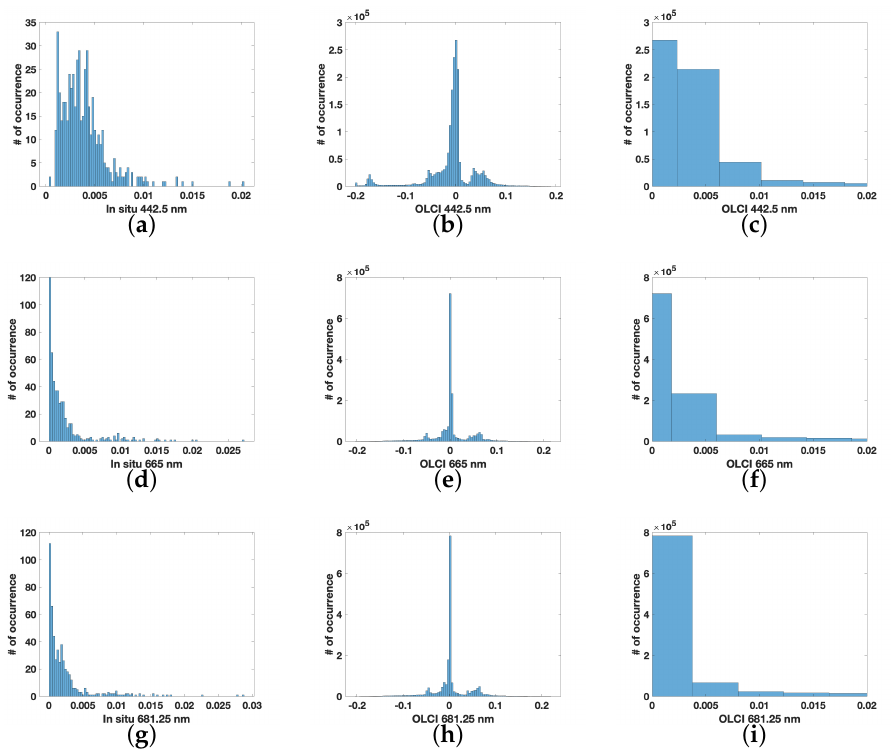
Figure 8. The histograms of the in situ Rrs used for training the ML GPR Balaton model ( a , d , g ), L2 OLCI Rrs ( b , e , h ) and L2 OLCI Rrs presented only the range corresponding to the in situ values ( c , f , i